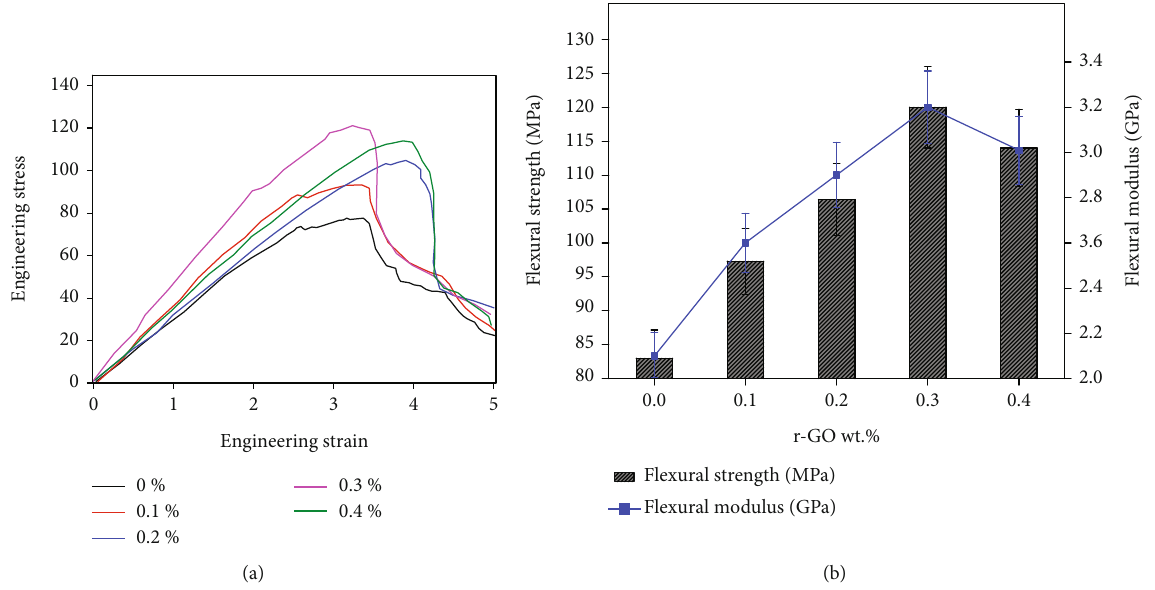
Figure 4: (a, b) Variation of fl exural strength with respect to r-GO addition.